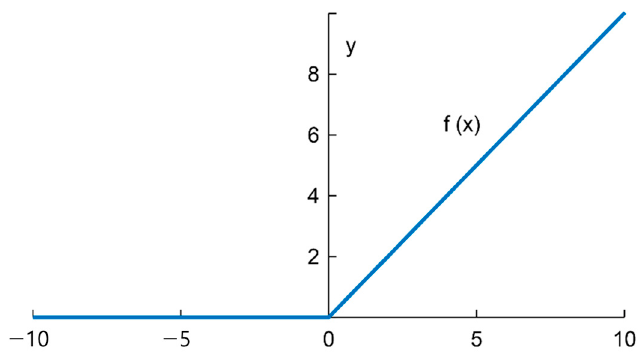
Figure 10. Schematic of the ReLU